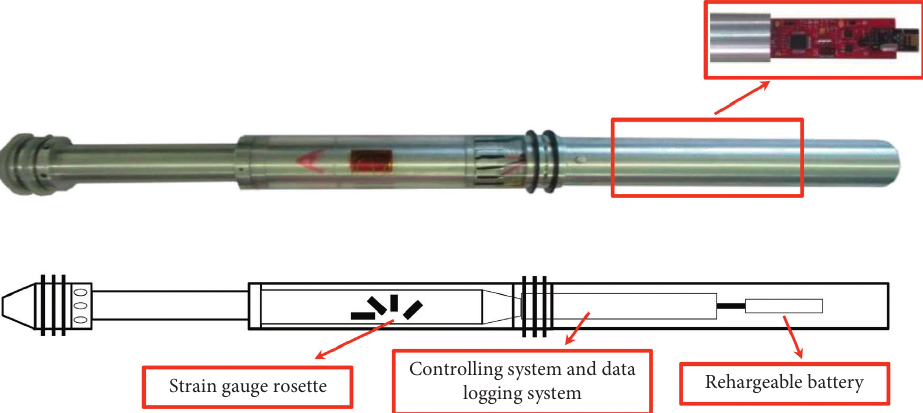
Figure 2: The used digital hollow inclusion strain gauge.